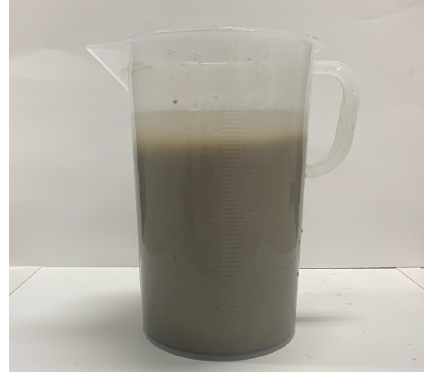
Figure 4. Concrete slurry water.